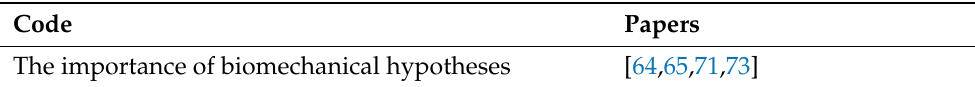
Table 5. The importance of biomechanical